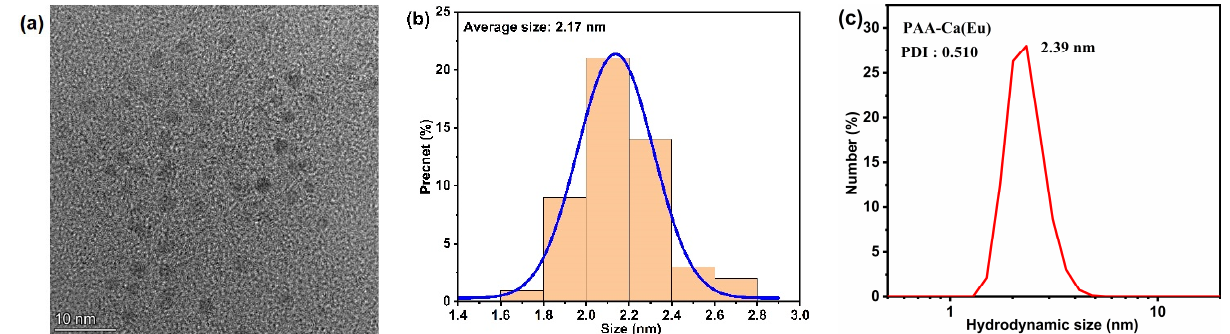
Figure 1. ( a ) High-resolution transmission electron microscopy image of PAA-Ca (Eu) nanoclusters; ( b ) Particle size statistics of ( a ); ( c ) Hydrodynamic size of PAA-Ca(Eu) nanoclusters. In addition, FT-IR spectra of PAA-Ca (Eu) nanoclusters and samples with different PO 43 − additions are shown in Figure 2. The absorption peak at 3478 cm − 1 is the O-H stretching vibration peak in PAA molecule [28]. The absorption peaks at 1556 cm − 1 and 1401 cm − 1 are the asymmetric stretching vibration peak ( ν as (COO − )) and the symmetric stretching vibration peak ( ν s (COO − )) of COO − in the PAA molecule, respectively. Compared with pure PAA, the C=O absorption peak shifts to a low frequency and the C-O absorption peak shifts to a high frequency, which ν as (COO − )– ν s (COO − ) is approximately 150 cm − 1 , indicating that the coordination between carboxylic acid and the metal ions in PAA is a bridge coordination compound [29,30]. After adding PO 43 − , the absorption peak of the phosphate ion appeared obviously in the infrared spectrum, which was located at 1104 cm − 1 , 1072 cm − 1 and 536 cm − 1 , belonging to the asymmetric stretching ( ν 3 ) and the asymmetric angle change ( ν 4 ) of PO 43 − [31,32].